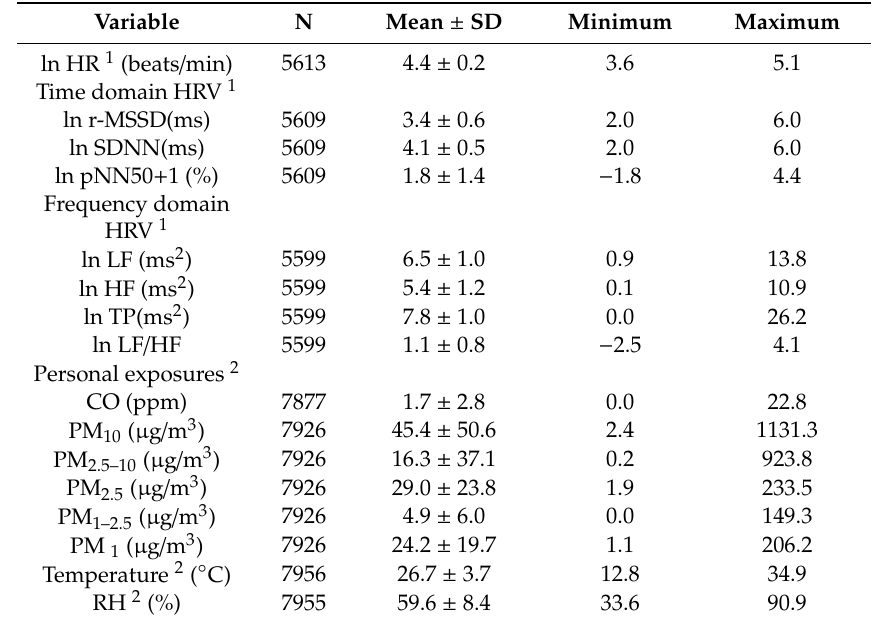
Table A1. Summary statistics for the participants’ air pollution exposures, heart rate variability and meteorological conditions using a 5-min